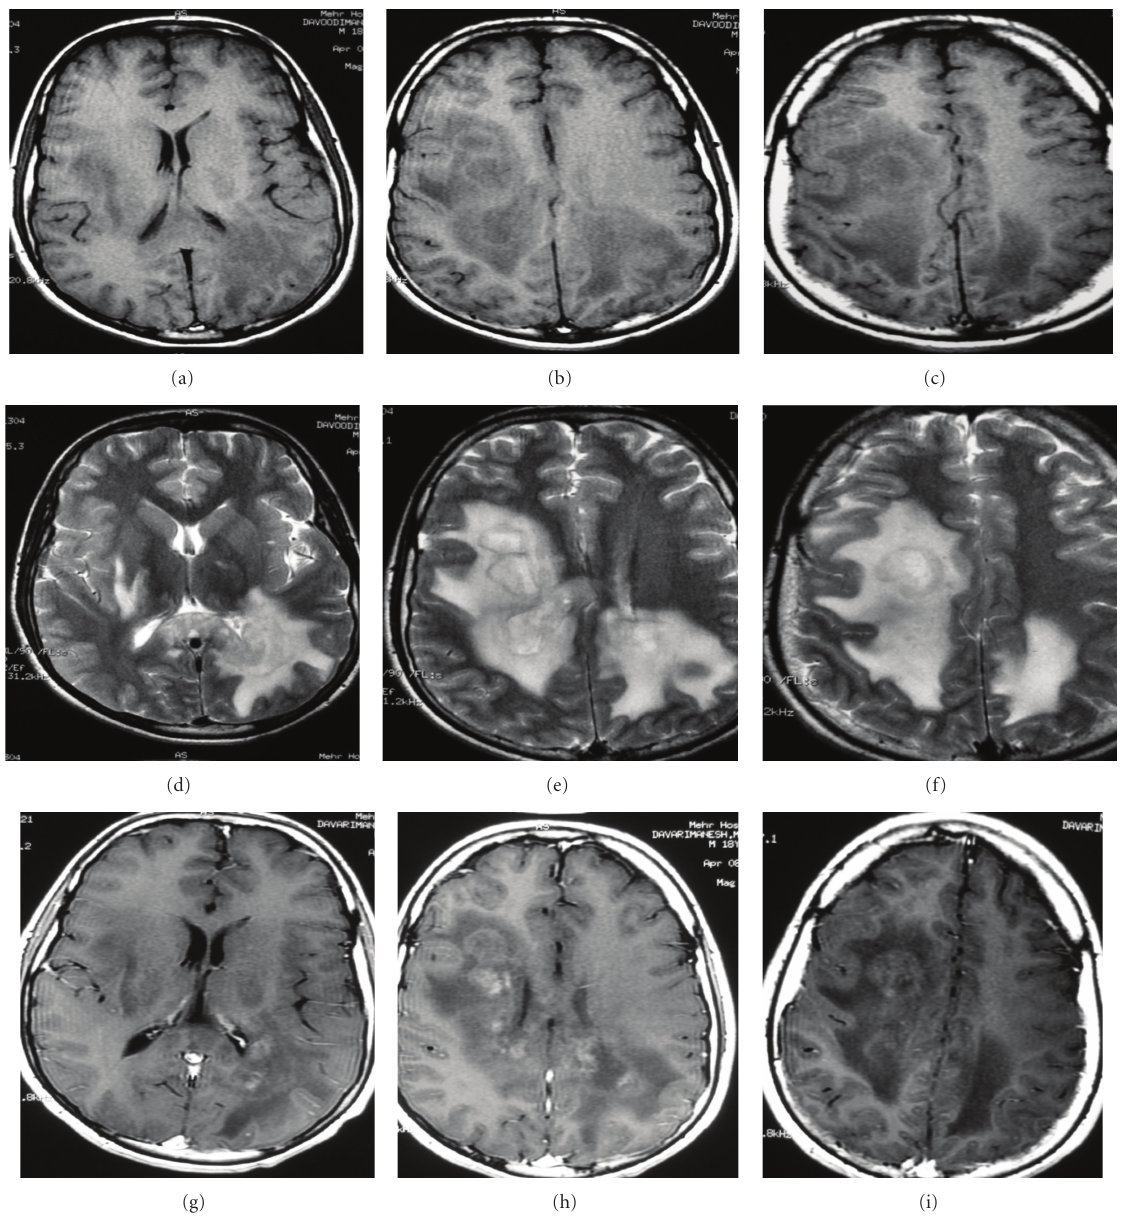
Figure 1: April 2008, axial T1WI ((a), (b), and (c)) and T2WI ((d), (e), and (f)) demonstrate multiple round-shaped lesions with low T2 and iso T1 margin and central low T1 and high T2 signal intensity in right centrum semiovale region and perileft occipital horn white matter, extending to splenium of the corpus callosum and are associated with peripheral vasogenic edema but mo mass e ff ect or midline structure shift was seen. On postcontrast T1 W images ((g), (h), and (i)), heterogeneous enhancement was noted in